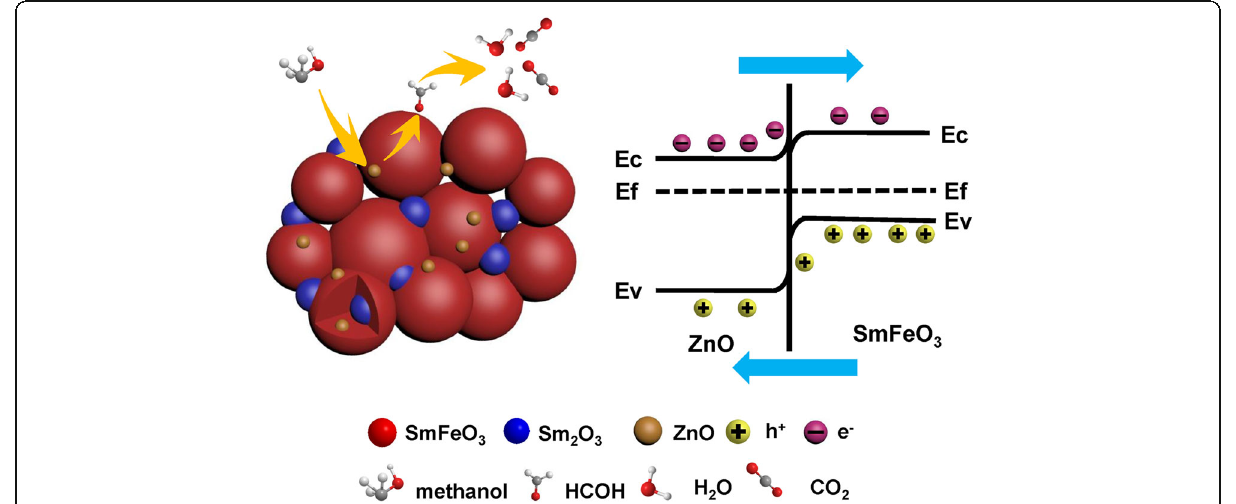
Fig. 11 The schematic diagram of Sm 2 O 3 /ZnO/SmFeO 3 p-n